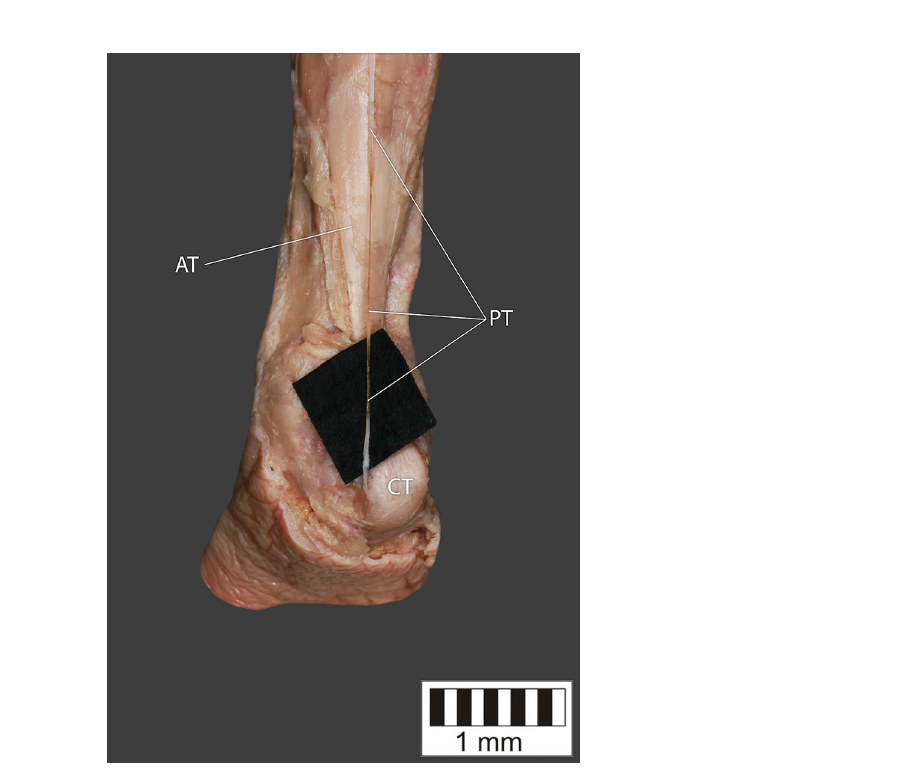
Figure 4. Type II of plantaris tendon. CT calcaneal tuberostity, AT Achilles tendon, PT plantaris